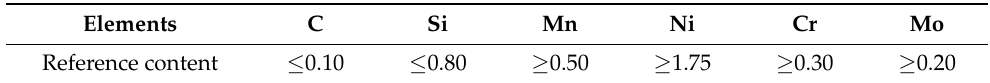
Table 2. Chemical composition of J857CrNi deposited metal (wt.%).